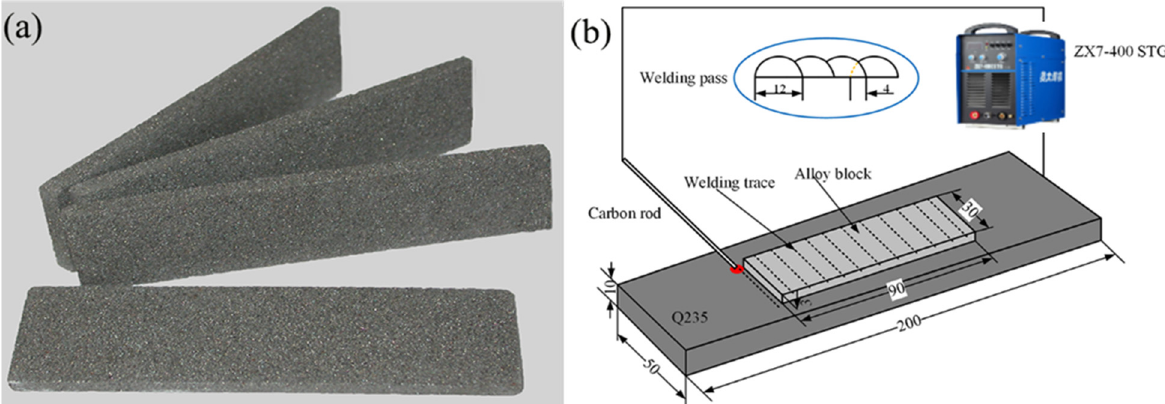
Figure 1. Alloy blocks and schematic diagram of the carbon arc surfacing (Unit: mm). ( a ) Alloy blocks, ( b ) Schematic diagram of the carbon arc surfacing.